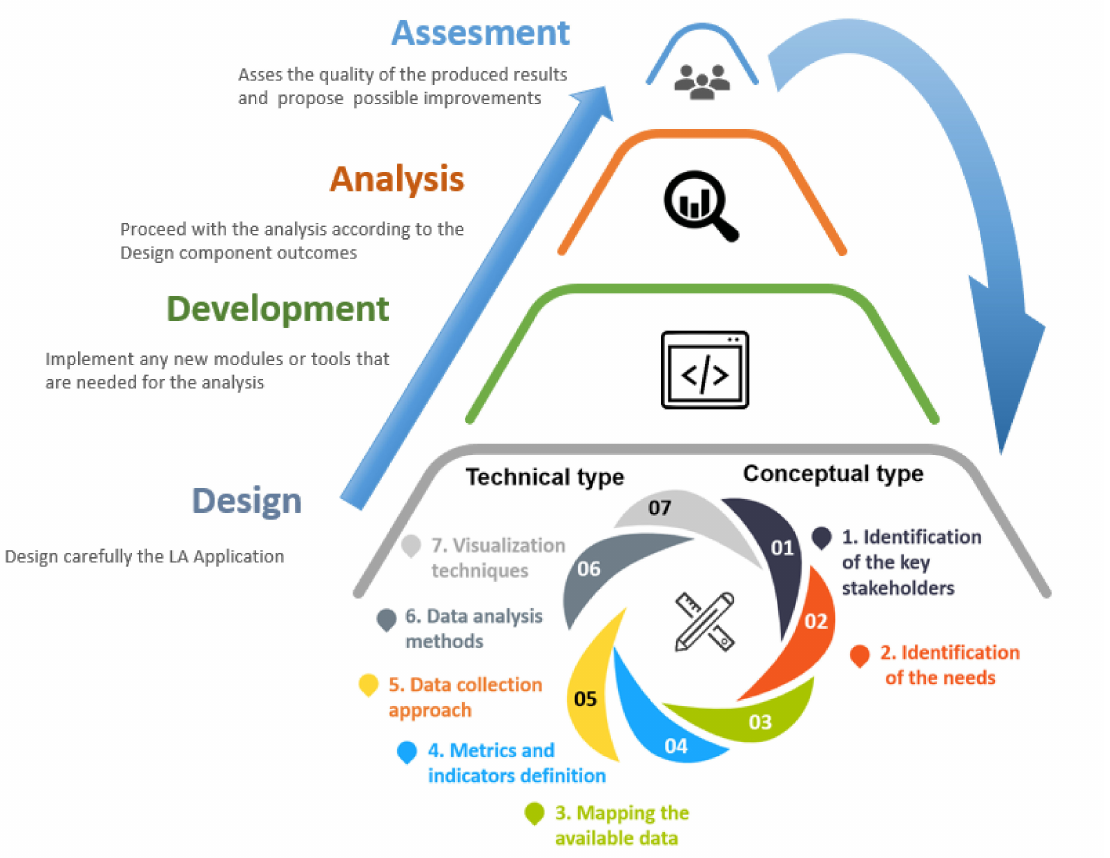
Figure 1. Overall architecture of the proposed learning analytics (LA)